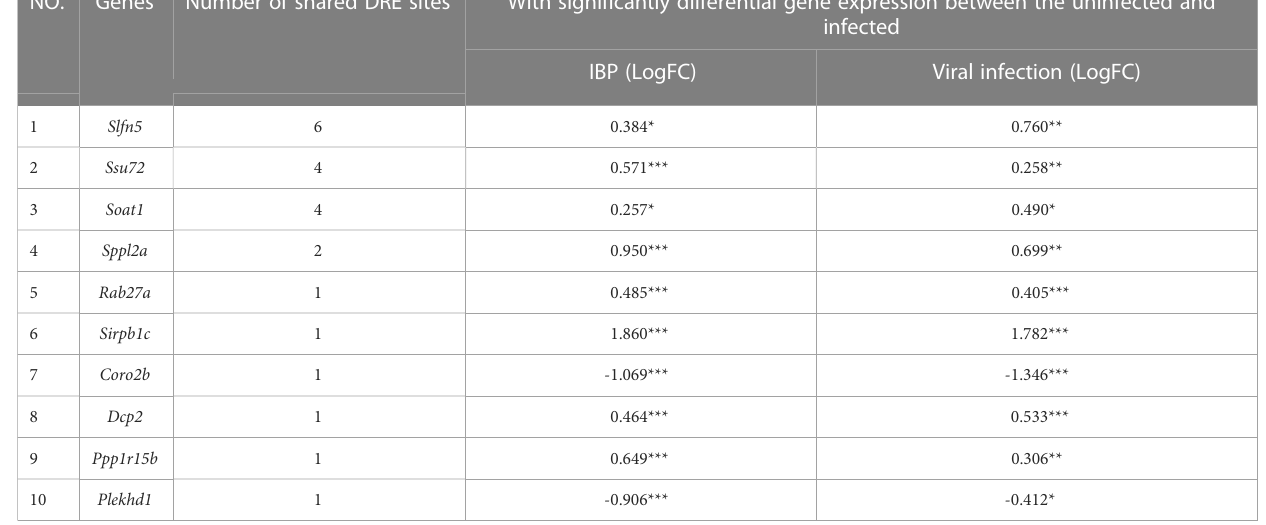
TABLE 2 Ten genes with the largest shared counts of DRE sites between IBP and viral infection models. NO. Genes